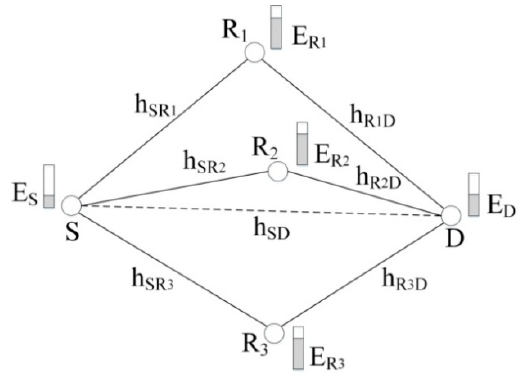
Figure 1. Cooperative transmission model.